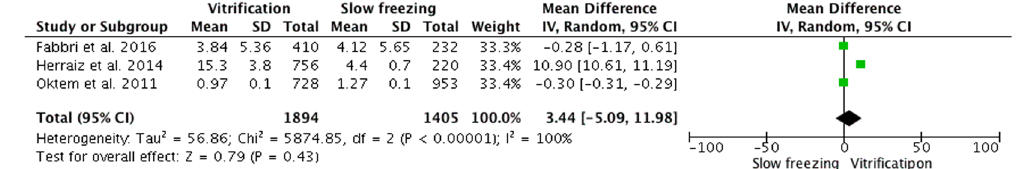
Figure 5. Random effect model of the mean difference with 95% CIs of the primordial follicle density: slow freezing versus